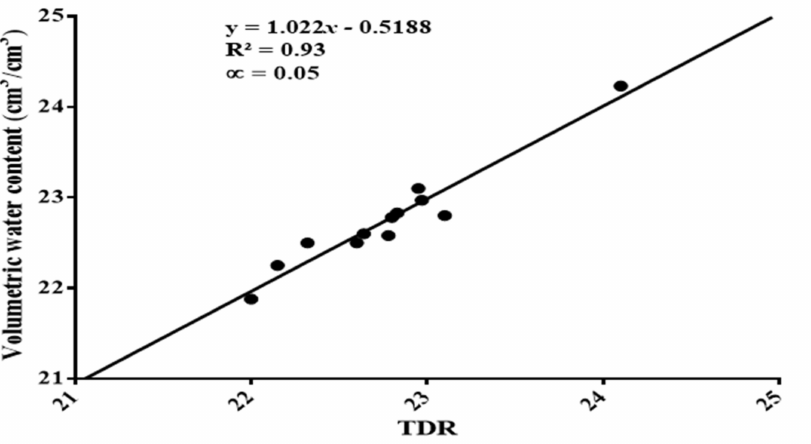
Figure 2. Correlation between soil volumetric water content and TDR